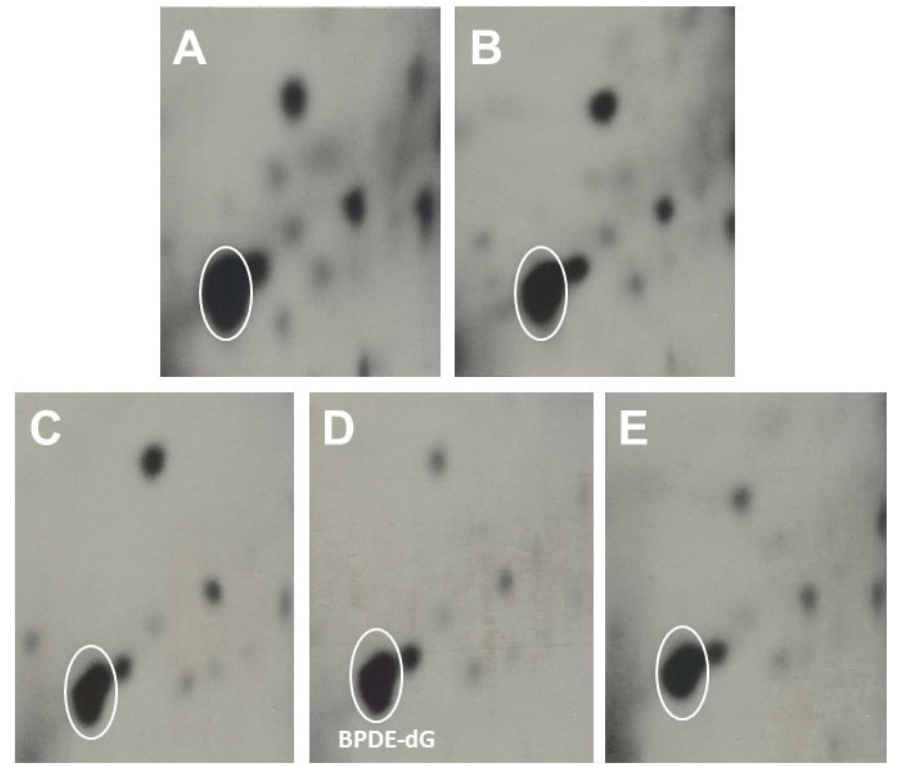
Figure 3. Representative patterns of 32 P-postlabeled pulmonary DNA adducts in A/J male mice, fed CO, FO, EPA or DHA, treated with BP. Panel ( A ), CO; ( B ), FO, ( C ), EPA (high dose), ( D ), DHA (high dose), and ( E ), EPA + DHA.